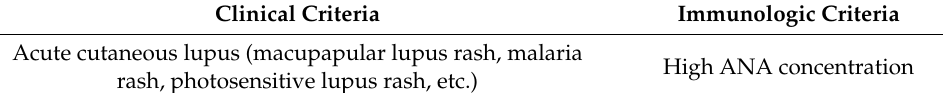
Table 1. SLICC CRITERIA. Clinical Criteria Immunologic Criteria Acute cutaneous lupus (macupapular lupus rash, malaria rash, photosensitive lupus rash, etc.) Chronic cuteness lupus (discoid rash, mucosal lupus, etc.)